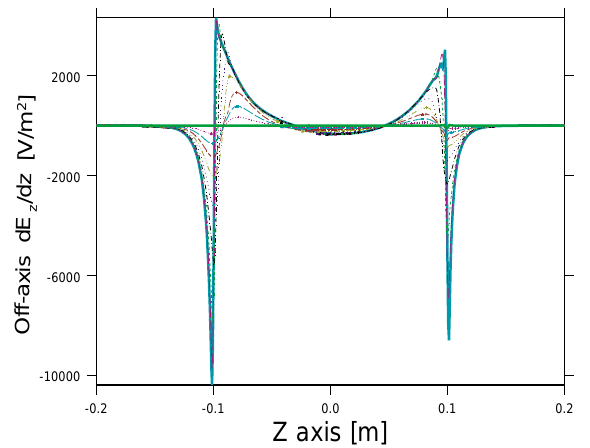
FIG. 6. (Color) Off-axis field derivatives ≠ E z (cid:3) ≠ z as functions of z for different radii: 0 # r # 2 cm for the beam bunch of Fig. 1.